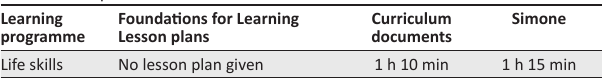
TABLE 4: Comparison of the allocation of times in different sources in Simone’s case.